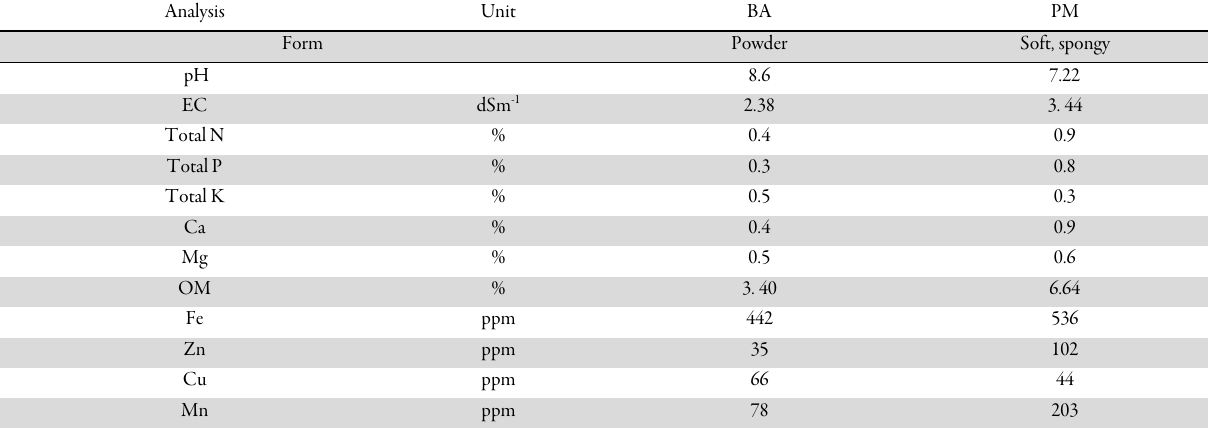
Table 2. Chemical analysis of BA and PM used in this